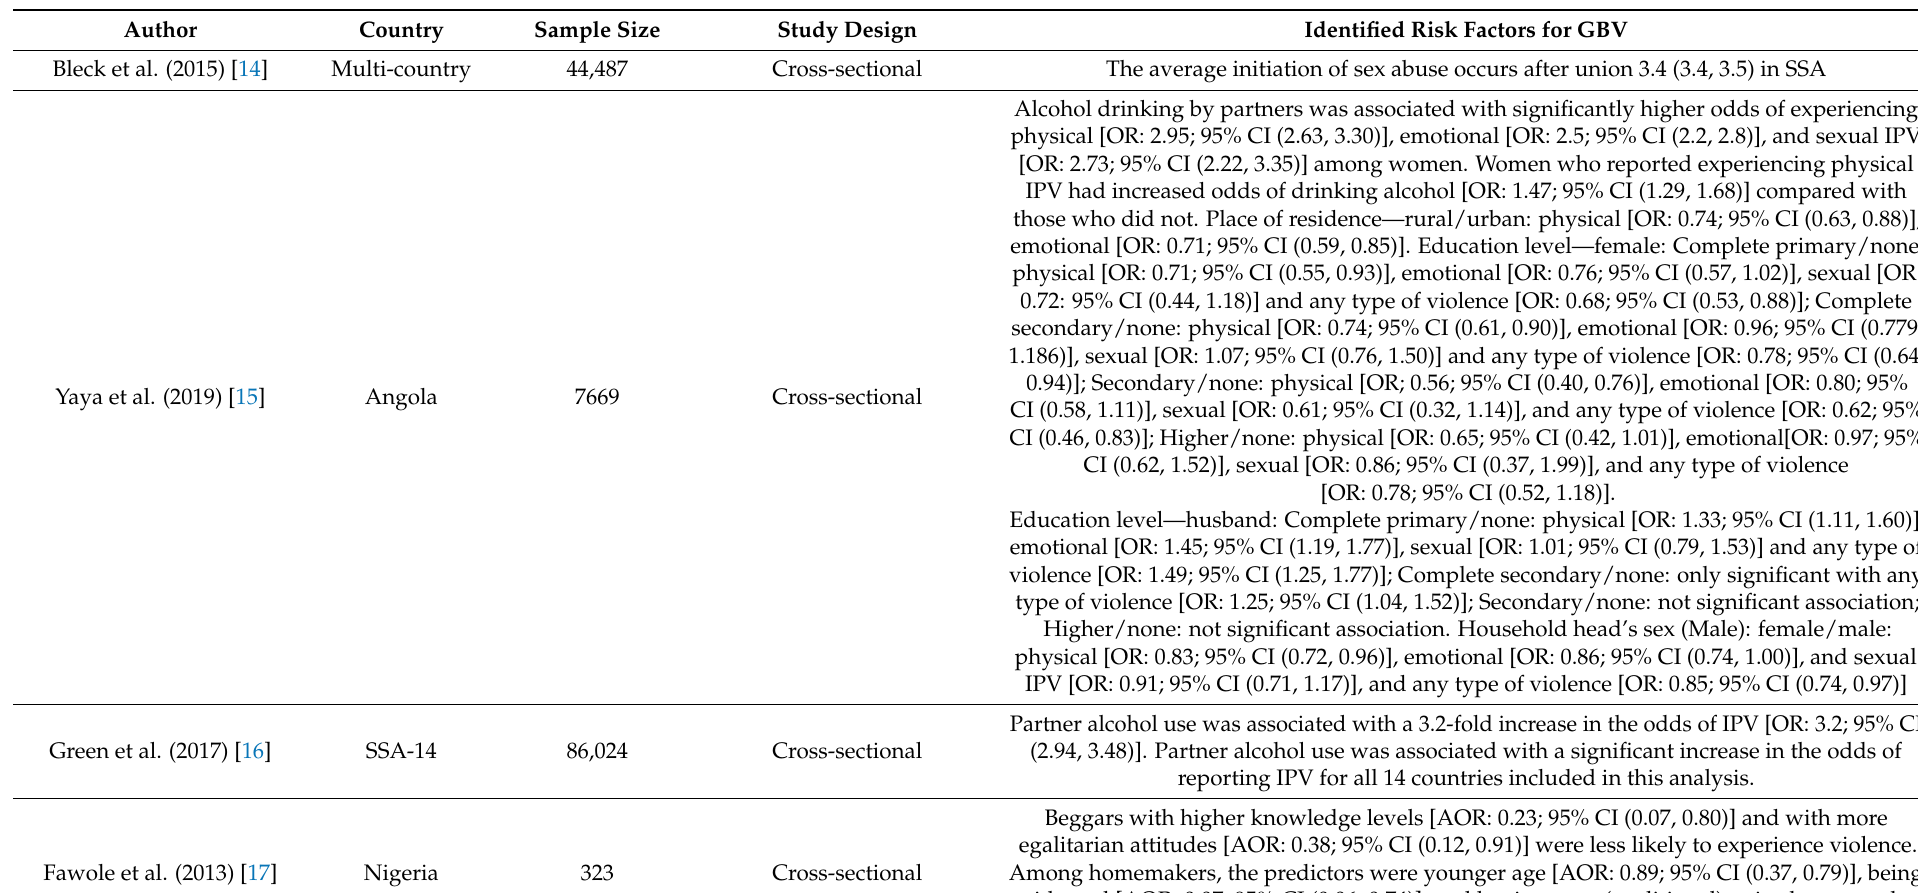
Table 1. Summarised description of studies on the risk of